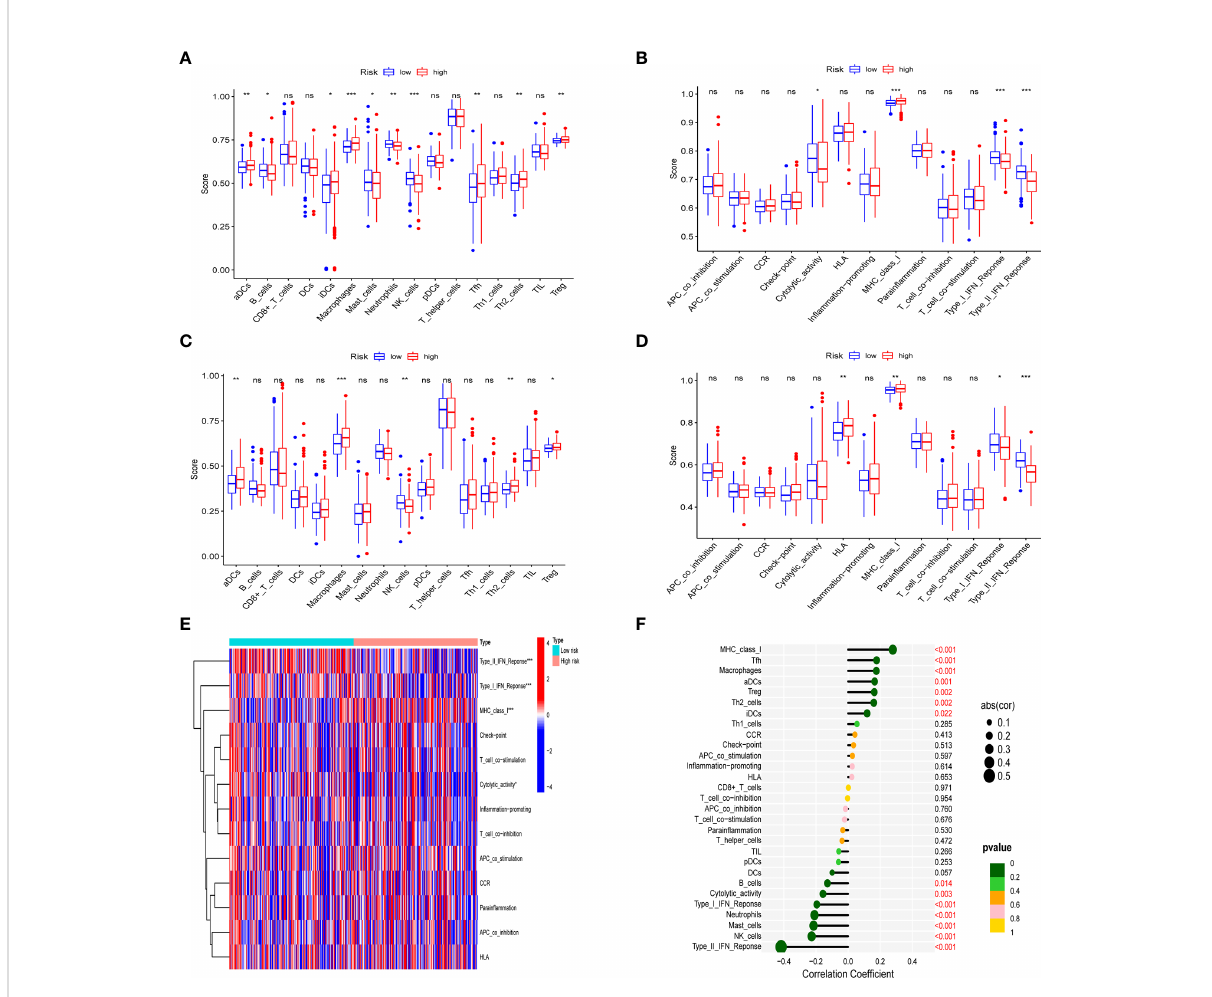
FIGURE 7 Analysis of immune status in different risk groups. Comparison of the ssGSEA score of immune in fi ltrating cells and immune-related functions in different risk groups. TCGA cohort (A, C) , ICGC cohort (B, D) . (E) The heatmap of immune-related functions in different risk groups in the TCGA cohort (F) The lollipop plot depicting the link between immune in fi ltrating cells and risk scores; node size represents correlation coef fi cient; node color represents P-value. *p < 0.05, **p < 0.01, ***p < 0.001; ns, no signi fi